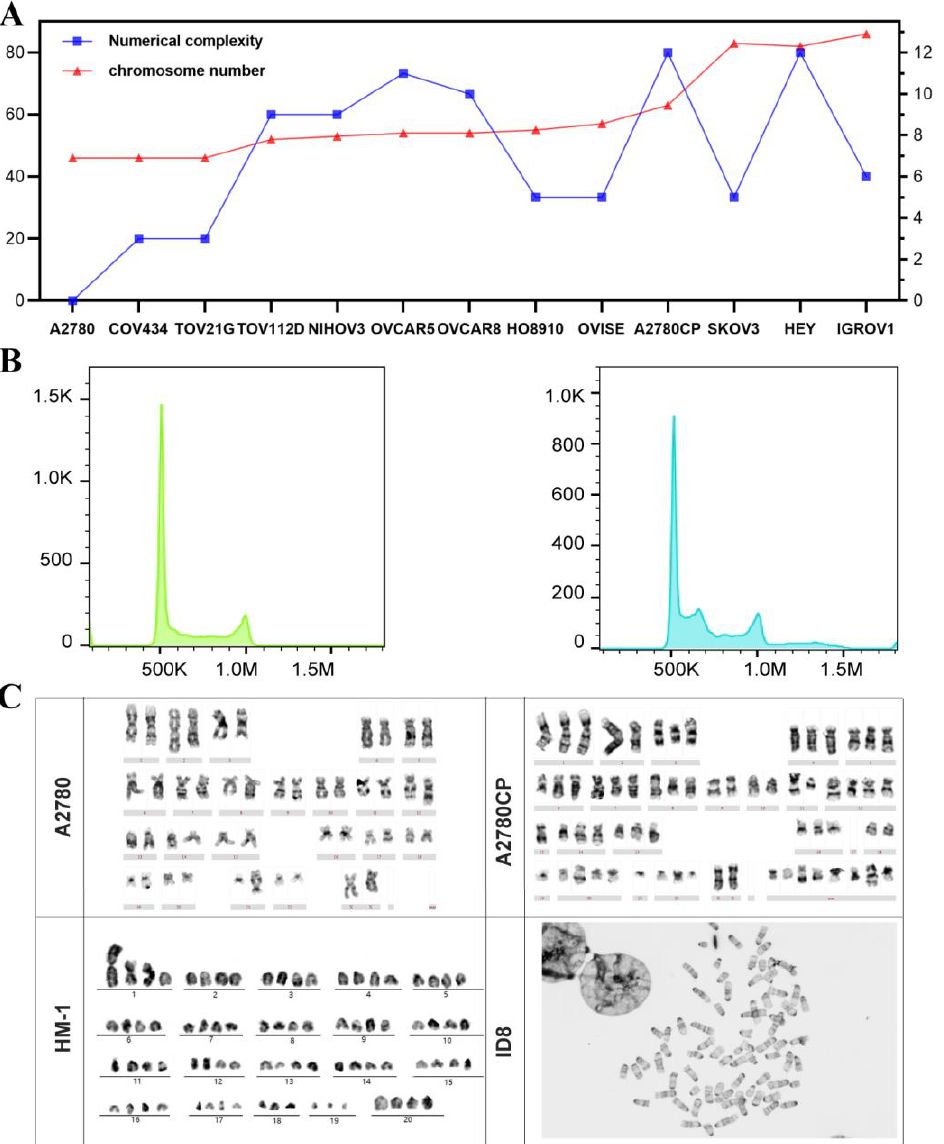
Figure 2. Karyotype and ploidy analysis of 13 commonly used ovarian cancer cell lines. ( A ): Chromosome modal number and numerical complexity of 13 human ovarian cancer cell lines. ( B ): Ploidy analysis of cell lines using flow cytometry. (Left panel: diploid cell line COV434; Right panel: COV434 mixed with SKOV3 in a ratio of 1:1). ( C ): Representative figures of karyotype analysis of human diploid and aneuploid cell lines and murine cell lines. Table 1. Karyotype analysis of 13 commonly used ovarian cancer cell lines.